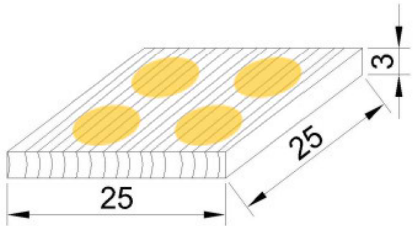
Figure 1. The same four places on the top surface of specimen in which colour measurements were performed in its original and fungal-attacked state.